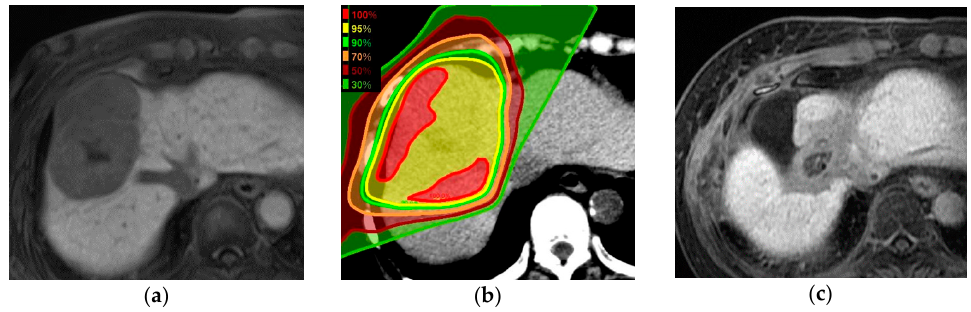
Figure 2. HCC (7.9 × 5.6 cm) treated by PBT (66 CGE/10 fractions) in a female in her eighties with hepatitis C liver cirrhosis, Child–Pugh class A. Tumor shows hypo-intensity in the hepatobiliary phase of gadolinium ethoxybenzyl diethylenetriamine pentaacetic acid-enhanced MRI (EOB-MRI) before treatment ( a ). The isodose lines displayed on planning CT ( b ). Three years on from PBT, the tumor was reduced in size on EOB-MRI. The normal liver in the irradiated area was atrophied, but severe liver damage was not observed ( c